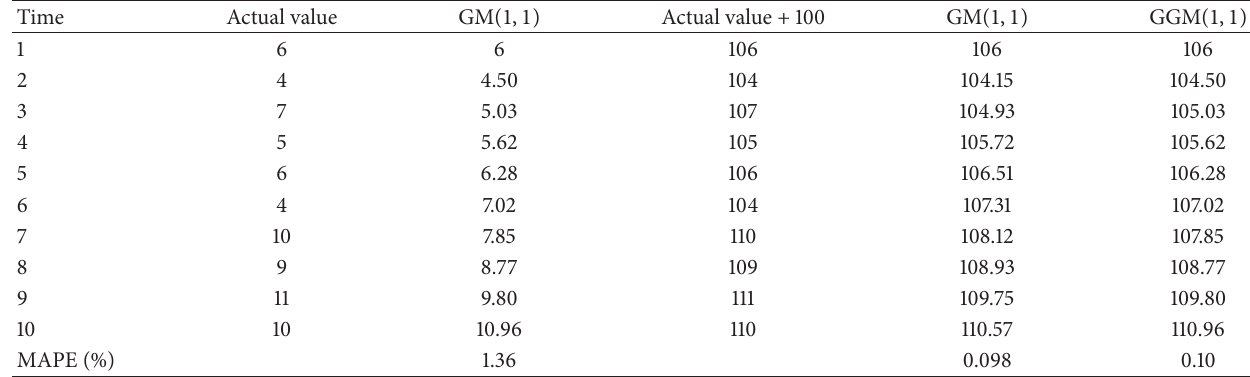
Table 1: Simulation by GM( 1, 1 ) and GGM( 1, 1 ).